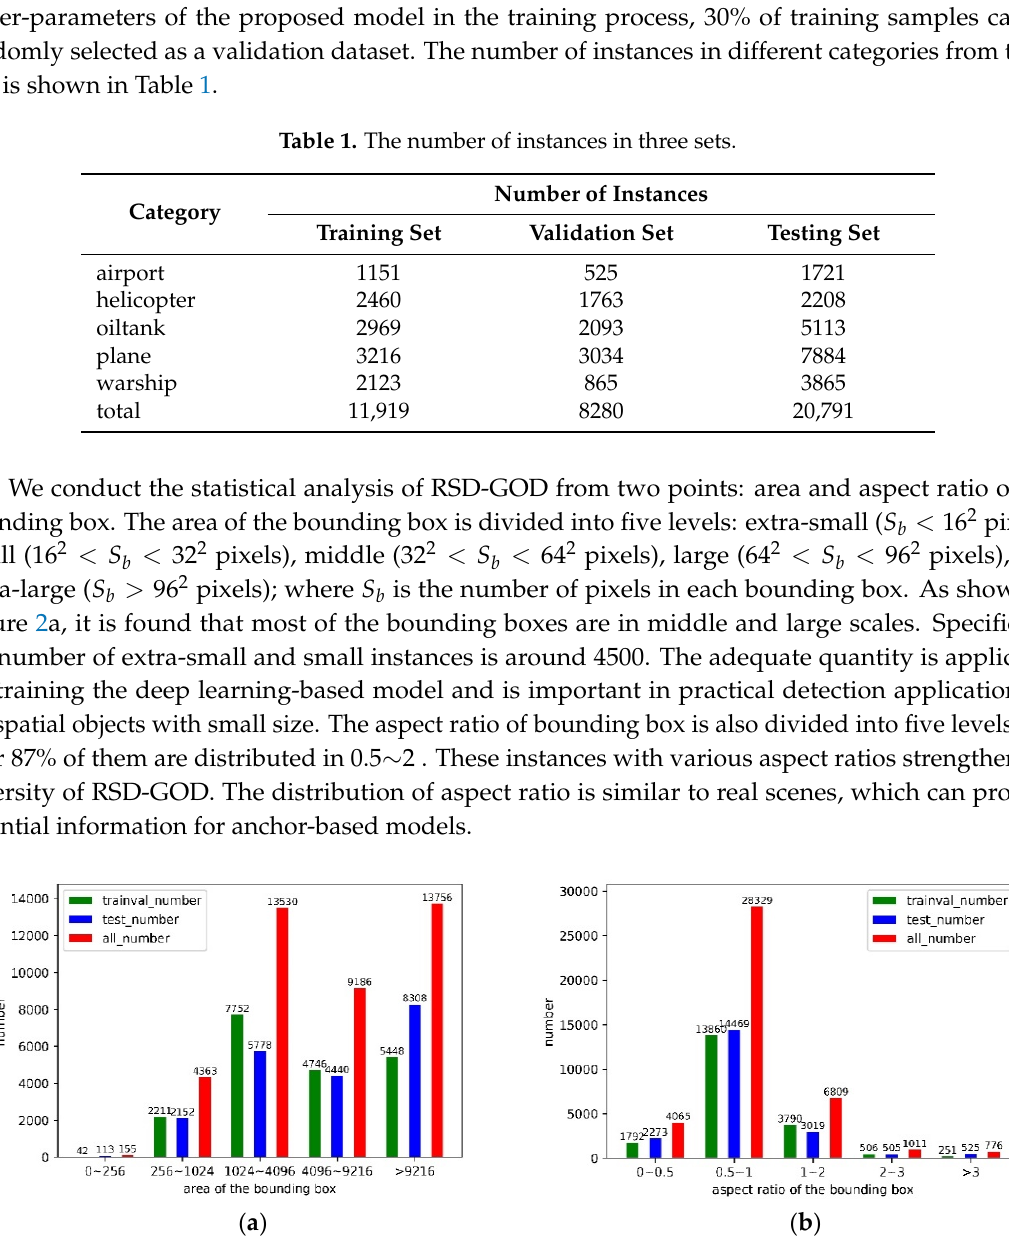
Figure 2. Statistical information of the constructed RSD-GOD. Statistical results of the training-validation, testing and the entire dataset are depicted as bars with different colors. ( a ) Number of instances with different area of the bounding box in different datasets; ( b ) number of instances with different aspect ratio of the bounding box in different